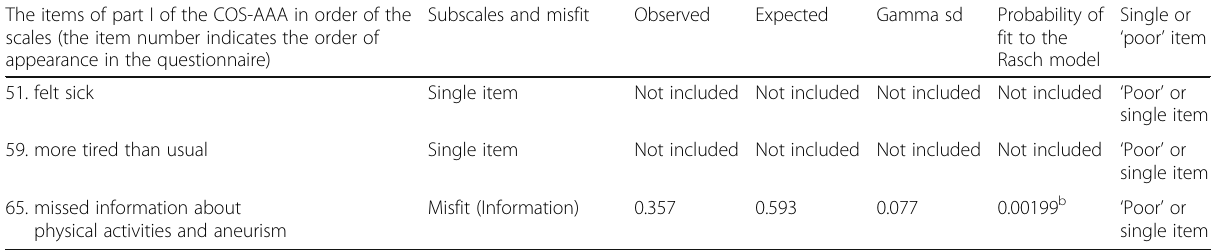
Table 3 Summary of result from the psychometric analyses of part 1 of the COS-AAA (Continued) The items of part I of the COS-AAA in order of the scales (the item number indicates the order of appearance in the questionnaire)